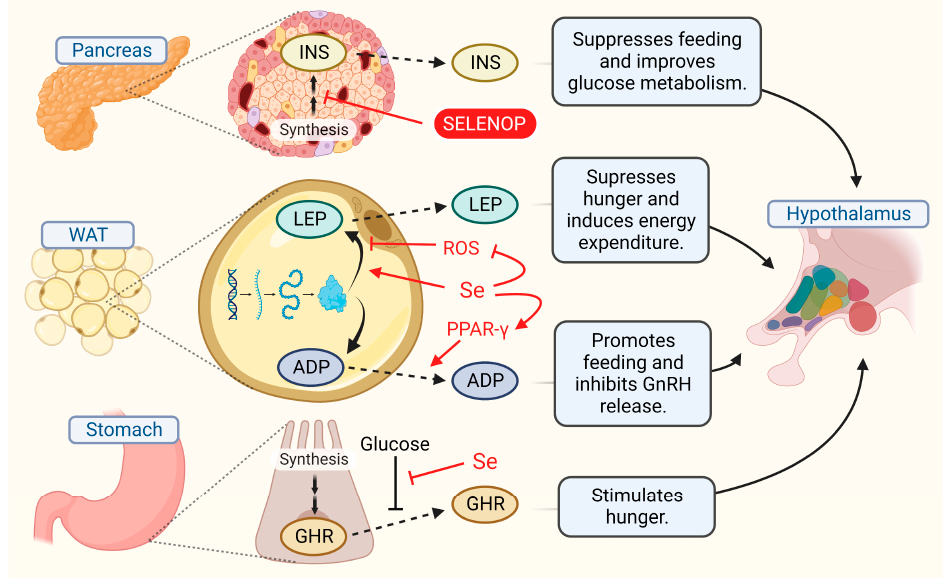
Figure 3. The potential effects of selenium on peripheral production of homeostatic signals to the hypothalamus. Although some studies report an insulin-like capability of selenium, the most direct evidence of an influence on pancreatic insulin (INS) secretion is the reported antagonism of insulin synthesis by the hepatokine selenoprotein P (SELENOP). In contrast, selenium plays a supportive role in the production and secretion of the hunger-suppressing adipokine leptin (LEP). Adiponectin, another adipose tissue-derived hormone, seems to be supported by selenium through a mechanism involving peroxisome proliferator-activated receptor- γ (PPAR- γ ). Finally, selenium also seems to support ghrelin (GHR) secretion from the gut by countering the suppressive effect of excess glucose. ROS: reactive oxygen species, WAT: white adipose tissue. Effects of selenium are shown in red.